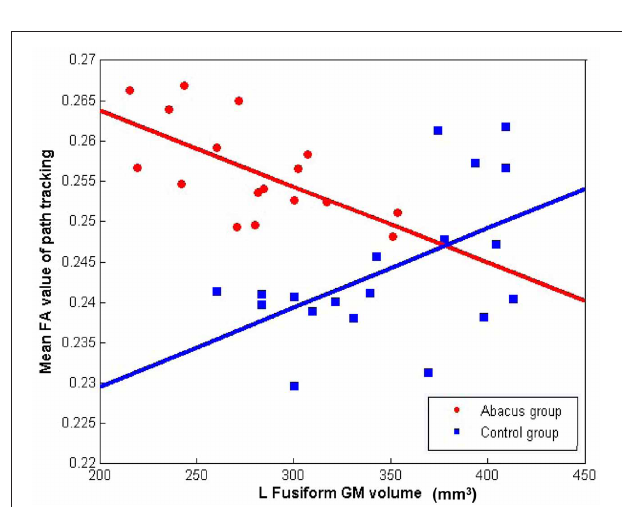
mask. (B) Mean fractional anisotropy within this white matter mask was significantly increased in children with abacus training. SD, standard deviation.